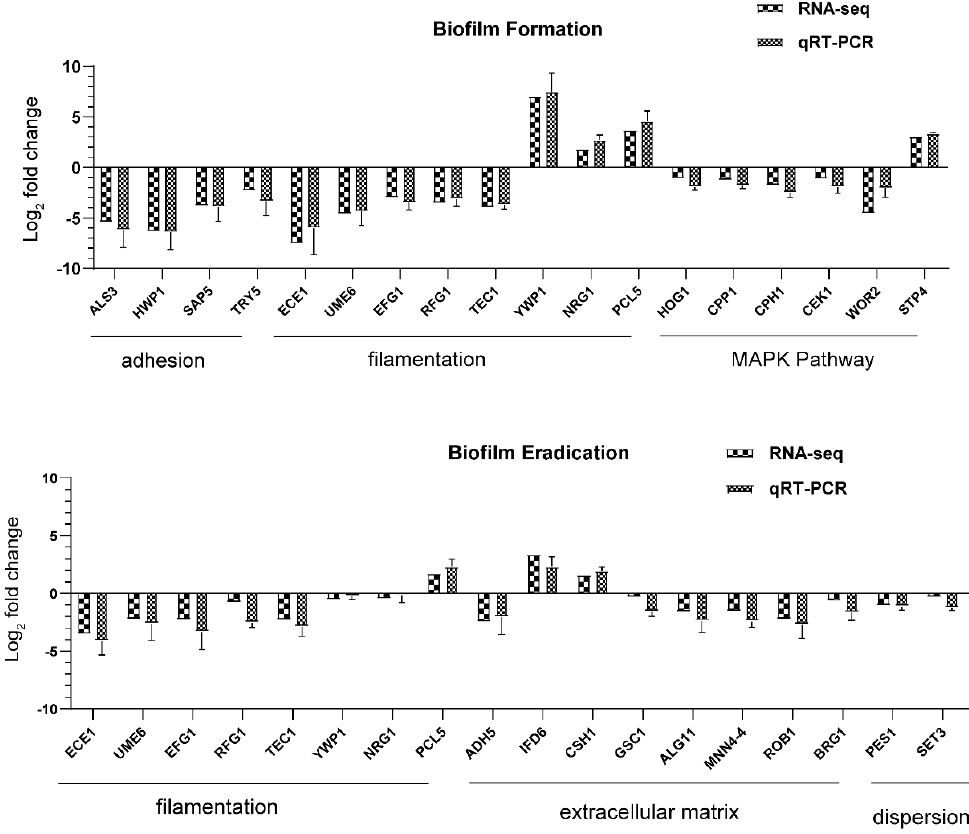
Figure 9. The fold change values of key genes were measured by RNA-seq and qRT-PCR. ( A ) The qRT-PCR gene expression trend of genes involved in biofilm formation was consistent with the RNA-seq analysis under 32 μg/mL AMP -17 treatment. ( B ) The expression trend of genes of preformed biofilm as characterized by qRT-PCR was consistent with that of RNA-seq analysis under treatment with 128 μg/mL AMP -17. All values are based on three independent repeats and are presented as the mean ± SD.